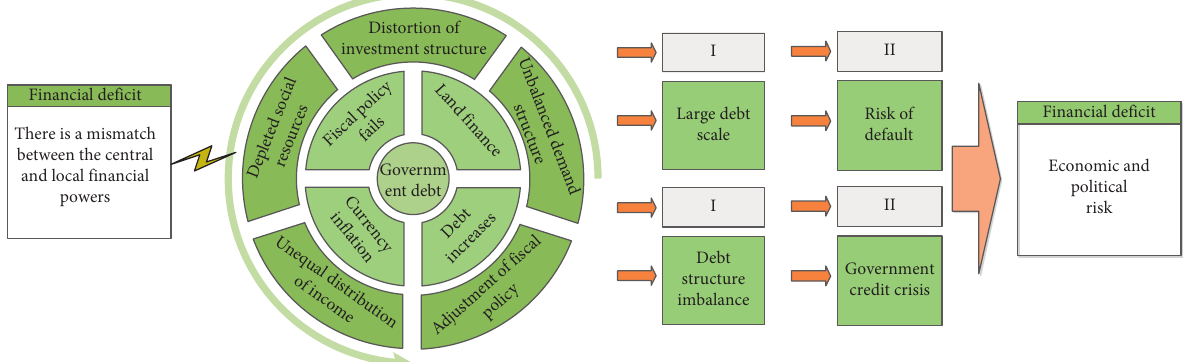
Figure 2: The internal logic of the relationship between government finance, debt risk, and government